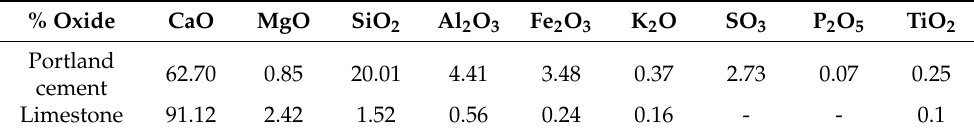
Table 2. Chemical composition of cement and limestone (% by mass of